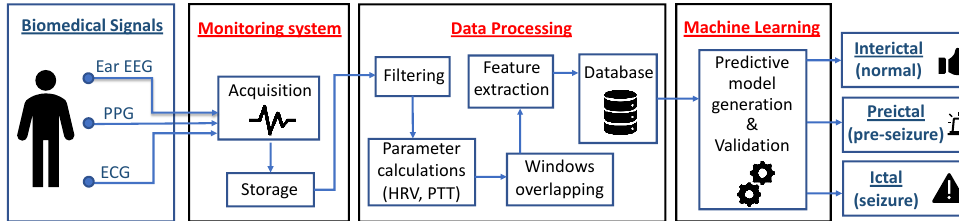
Figure 1. Flow diagram of the methodology.